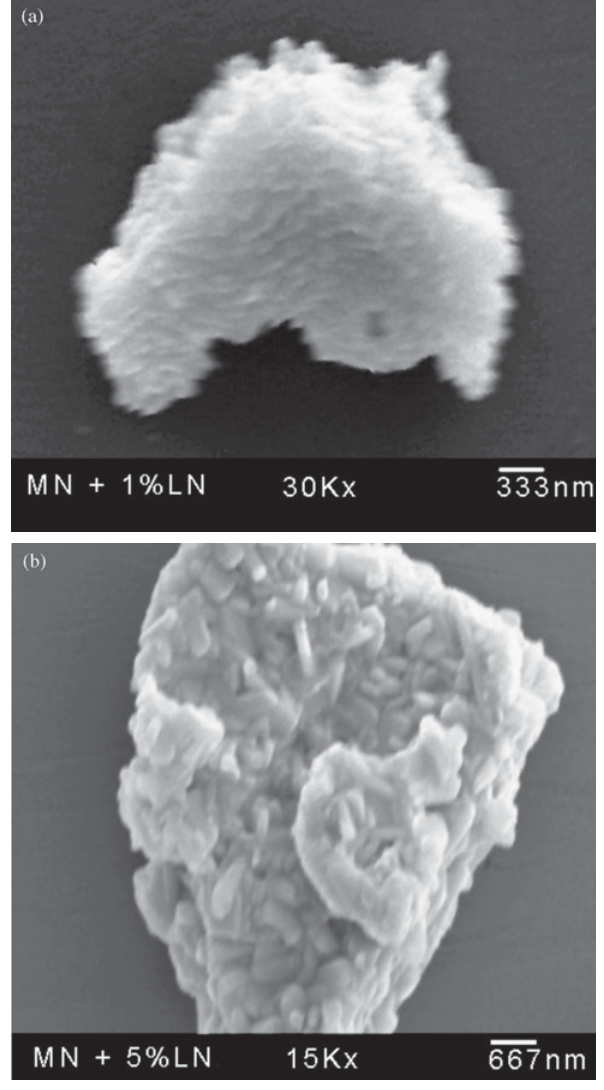
Figure 4. Scanning Electronic Micrographs for Li-doped MN